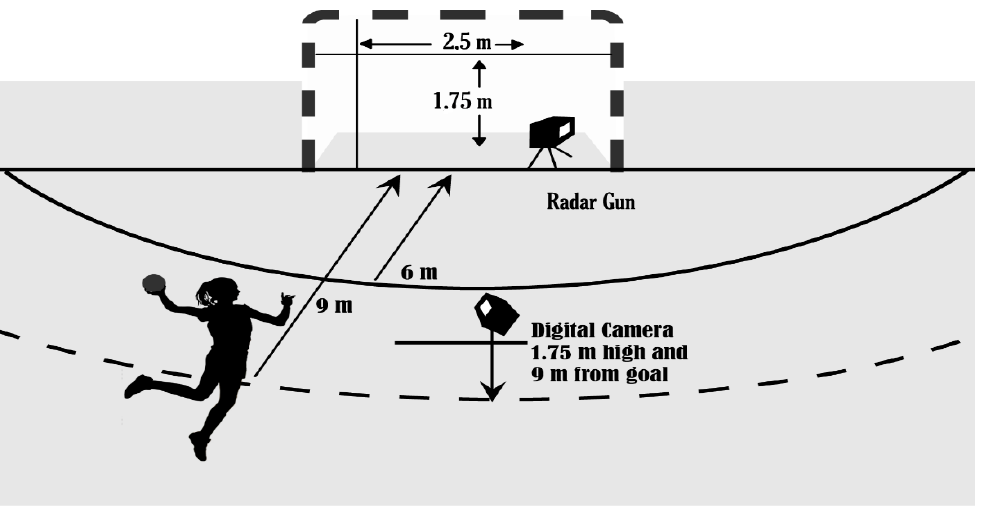
Figure 1. Graphical representation of the ball throwing task.